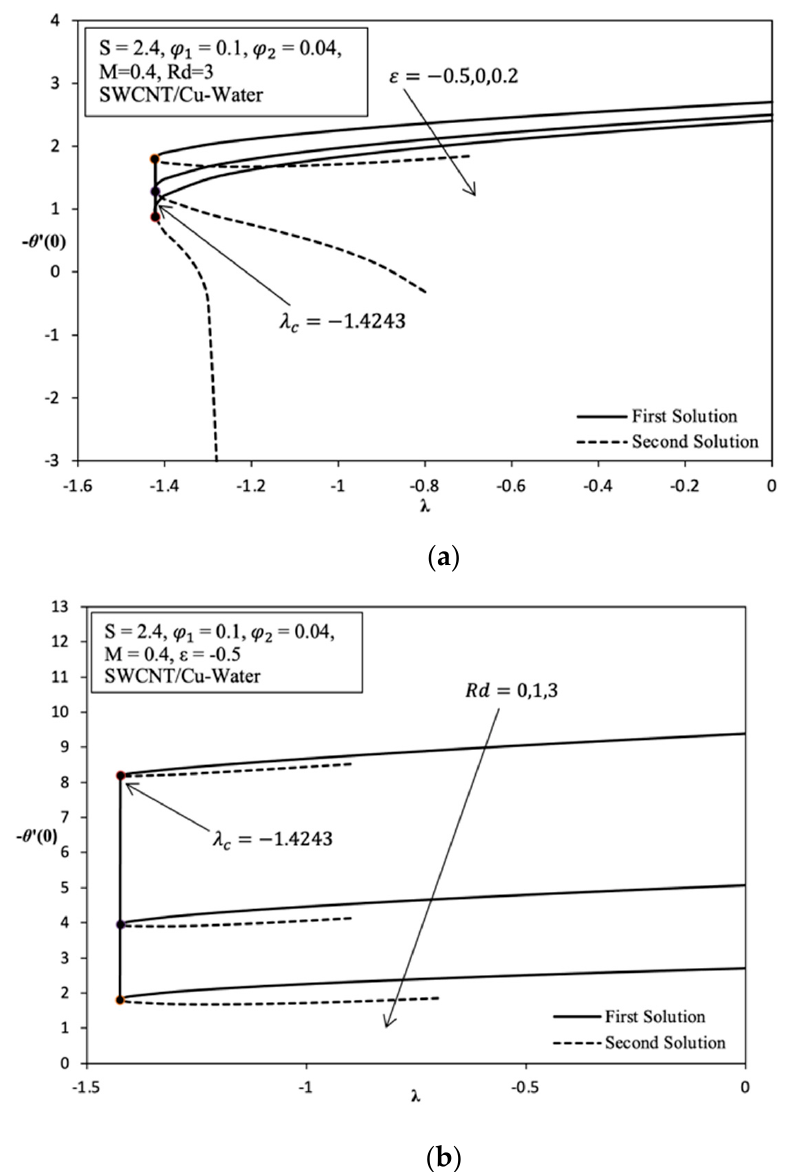
Figure 4. Variation of − θ ′ (0) versus λ for SWCNT/Cu–water with different values of: ( a ) ε when S = 2.4, ϕ 1 = 0.1, ϕ 2 = 0.04, M = 0.4, Gr = 0, and Rd = 3; ( b ) Rd when S = 2.4, ϕ 1 = 0.1, ϕ 2 = 0.04, M = 0.4 and ε = − 0.5.